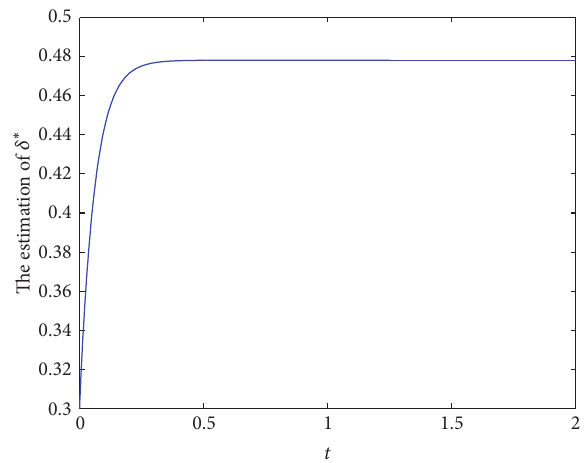
̂ 𝛿(𝑡) by updated law